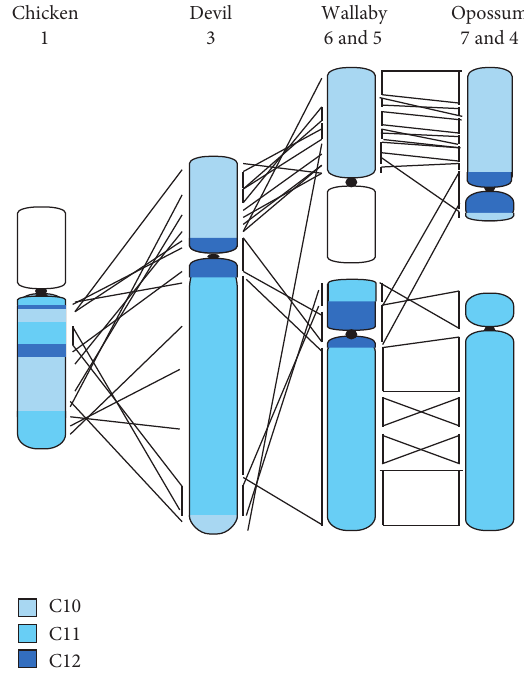
F 4: Arrangement of genes from conserved segments C10, C11, and C12 in chicken (outgroup) and marsupials. Most genes from these three segments are intermingled on chicken chromo- some 1. ey remain together on devil chromosome 3 but are distributed across two chromosomes both in the tammar wallaby and opossum, with independently derived breakpoints. Vertical lines indicated conserved blocks of